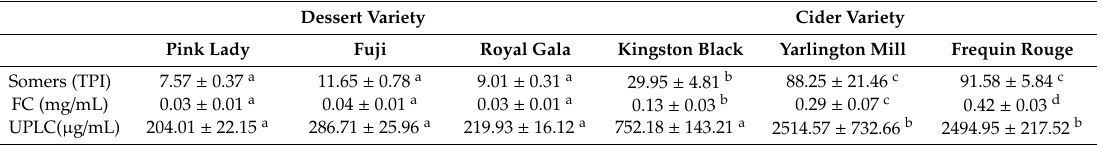
Table 2. Mean TPI ± standard error of the mean measured using the three methods for cider samples for each individual variety, separated by variety type. ( n = 12 for all dessert varieties, n = 18, 11, 12 for cider varieties, respectively). Di ff erent letters denote significant di ff erences between means at p ≤ 0.05. Dessert